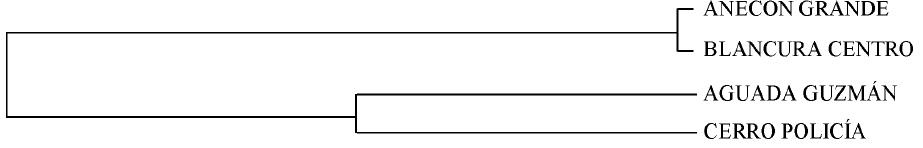
Figure 2 - Dendrogram of the Mapuche populations studied, obtained using Nei’s (1973) standard genetic distances and the neighbor-joining